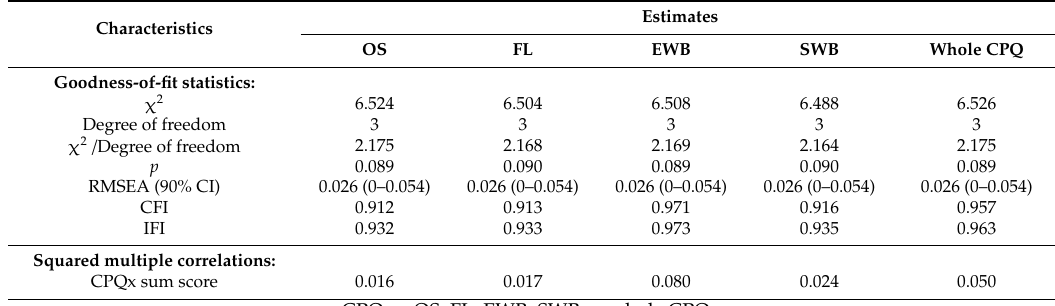
Table 4. Squared Multiple Correlations and Model Goodness-of-Fit Statistics for the four domains and the CPQ as a whole.